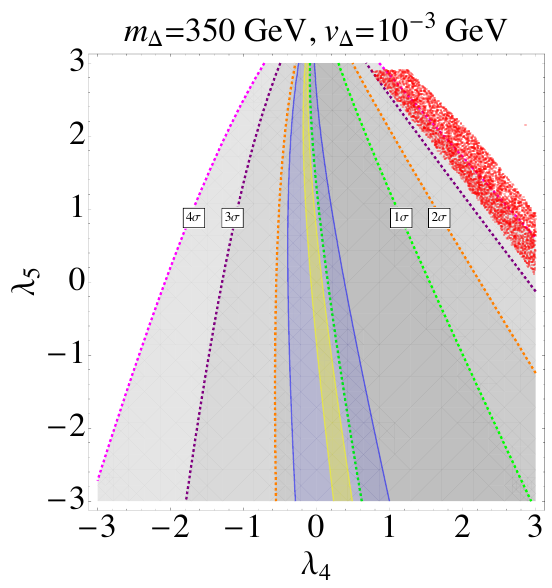
Figure 7 . Precision measurements of R hγγ from current and future circular colliders. The green, orange, purple and magenta boundaries represent the 1 σ , 2 σ , 3 σ and 4 σ regions from ref. [117]. The blue and the yellow regions are for a future 100 TeV collider FCC-ee and FCC-ee + FCC-pp, respectively. Our benchmark points are shown in the